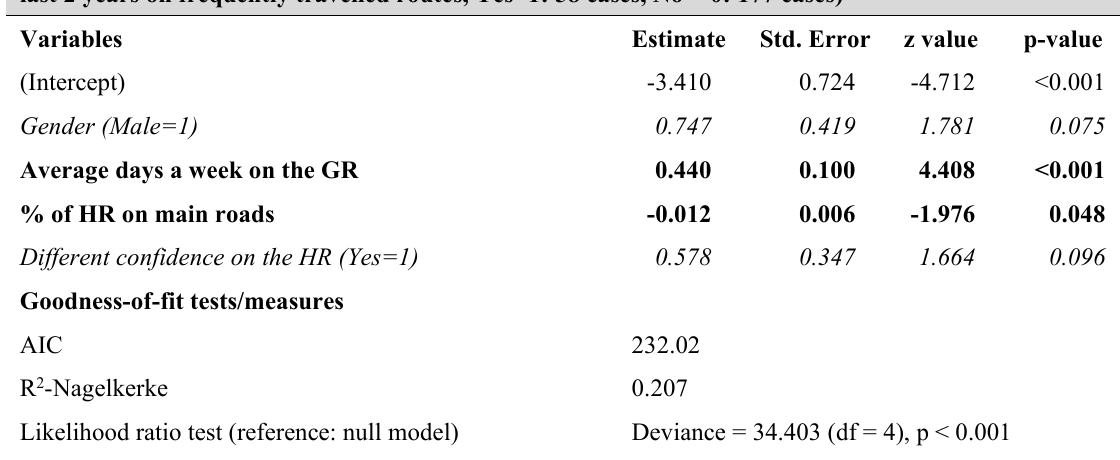
Table 3 Results from the different logistic regressions performed Italian model – response variable: Negative outcome on HR (at least one crash or fine reported in